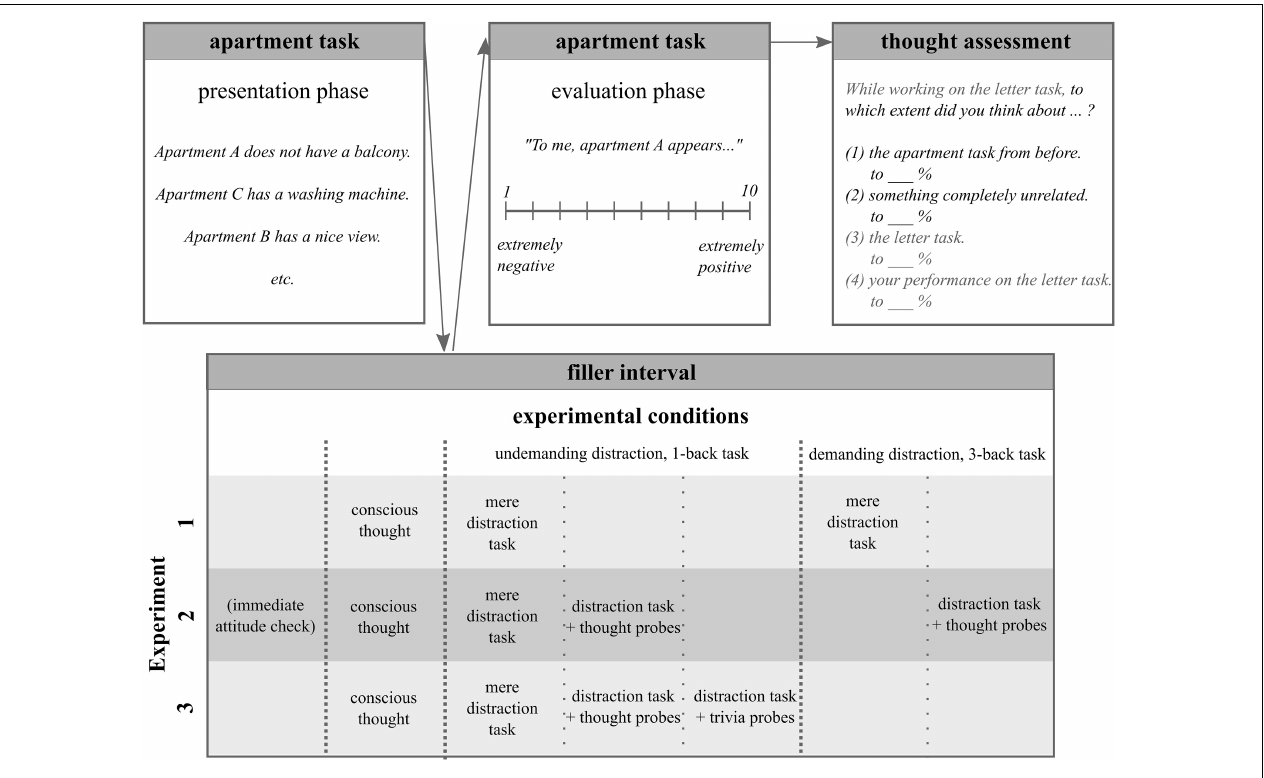
FIGURE 1 | Experimental procedure. All participants worked on the apartment task’s presentation phase and evaluation phase, with both phases being separated by a filler interval. The filler interval activity varied between experimental conditions and experiments. After evaluating the apartments, participants filled in a retrospective thought-assessment questionnaire, which related to their thoughts during the filler interval. Participants in the immediate evaluation condition (Experiment 2) made an exception to this general procedure, as they worked on both apartment task phases one after the other without a filler